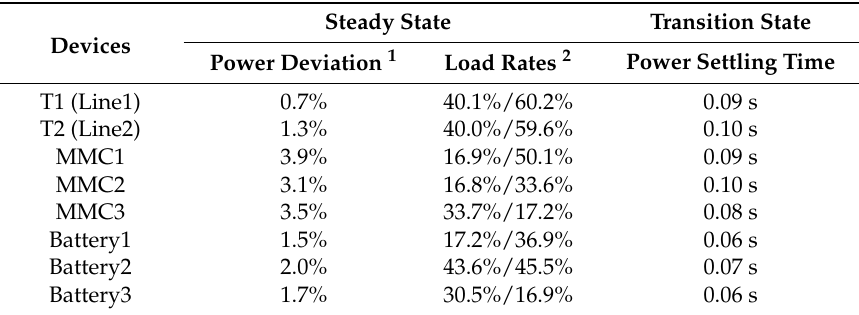
Table 5. Operation indexes during the limited condition of the